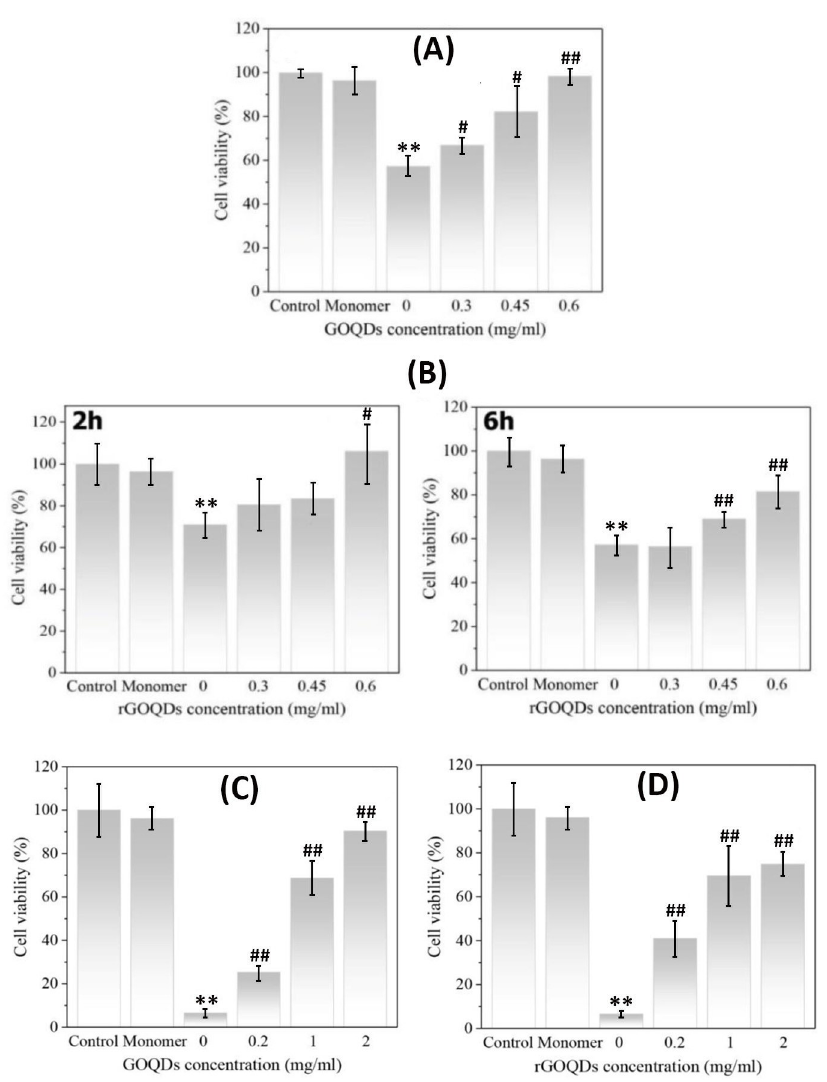
Fig 9. Protective effect of GOQDs and rGOQDs against cytotoxicity induced by bovine insulin and HEWL aggregates measured by MTT assay. For bovine insulin, SH-SY5Y cells were treated with 6-h-old insulin aggregates (10 μ M) aged alone, or in the presence of various concentrations of GOQDs (A); or 2-hours-old and 6-hours-old insulin aggregates (10 μ M) aged alone or in the presence of various concentrations of rGOQDs (B). For HEWL, SH-SY5Y cells were treated with HEWL aggregates (10 μ M) aged alone or in the presence of various concentrations of GOQDs (C) or rGOQDs (D). The data are expressed as percentage of values in untreated control cells. Each value represents the mean ± SD (n = 3). � p < 0.05; �� p < 0.01, were significantly different from control cells. # p < 0.05; ## p < 0.01, were significantly different from cells exposed only to bovine insulin/HEWL amyloid